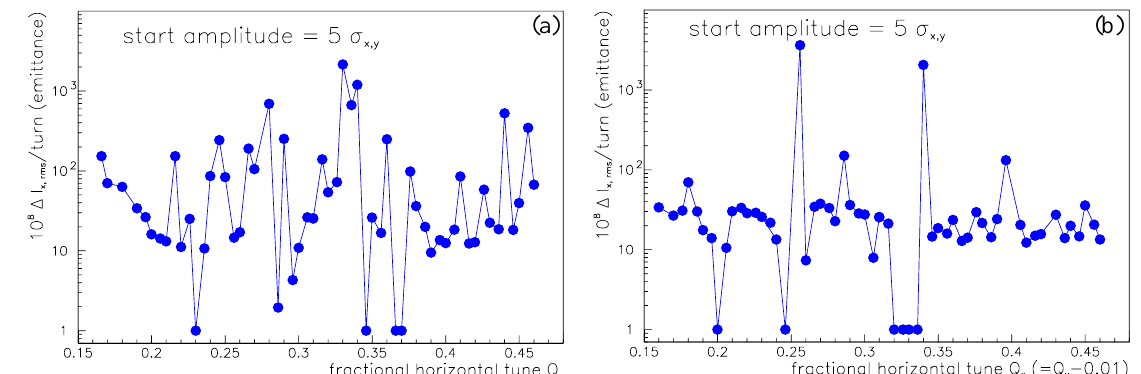
FIG. 11. (Color) The change of action variance per turn (in units of rms emittance times 10 2 8 ) as a function of the horizontal tune (a) for a constant vertical tune and (b) for both the tunes varying so as to keep a constant distance to the (cid:5) 1, 2 1 (cid:6) coupling resonance. The starting amplitude is 5 s in both planes.